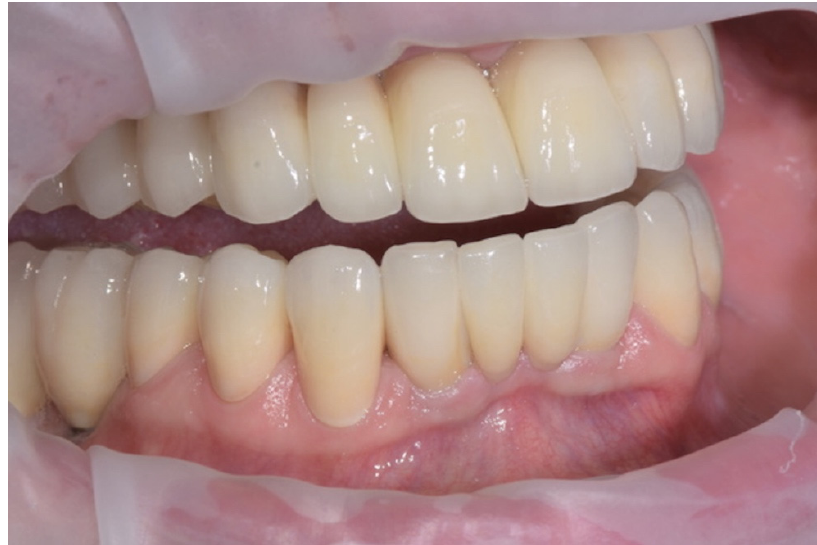
Figure 17. Crowns cemented.